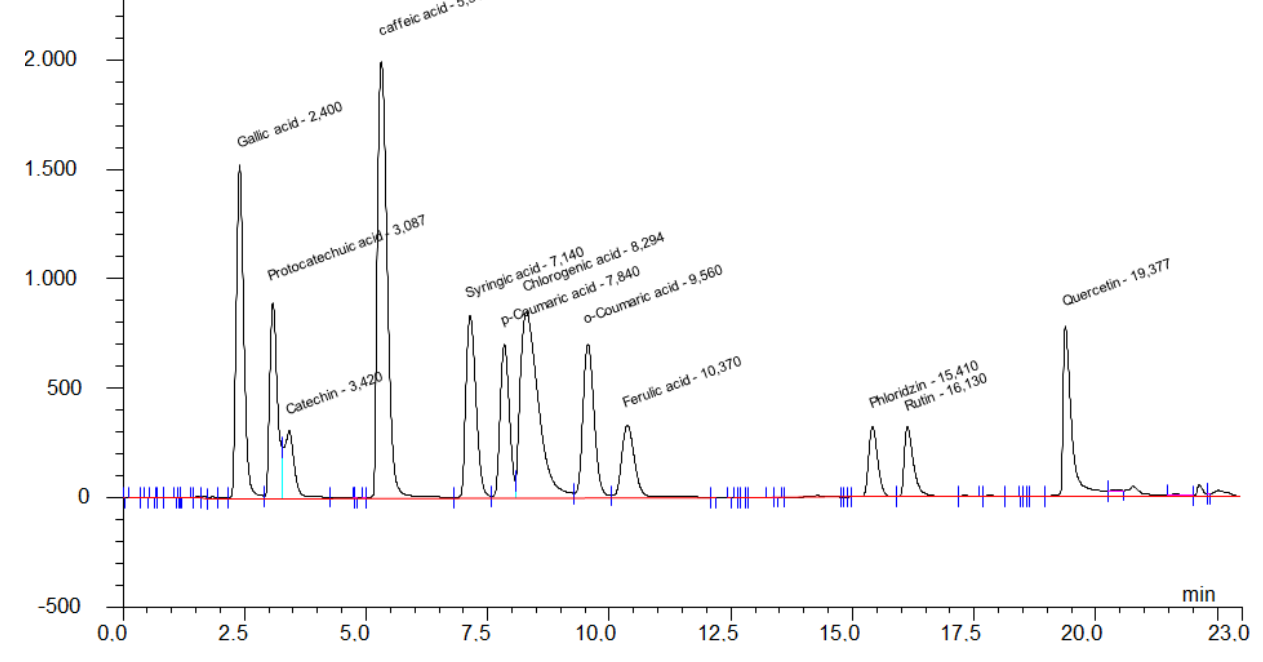
Figure 1. Chromatogram of phenolic compound standards.